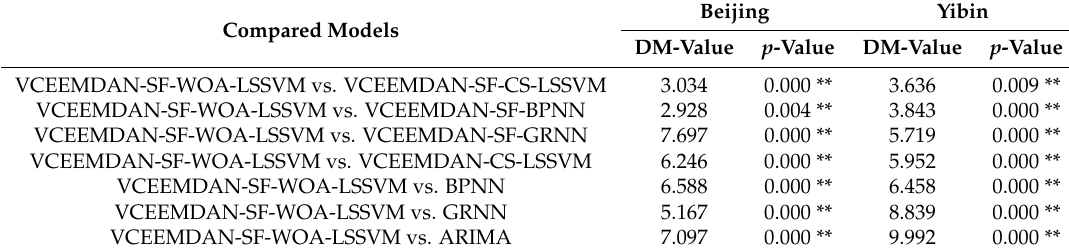
Table 8. Results of DM test for Experiment